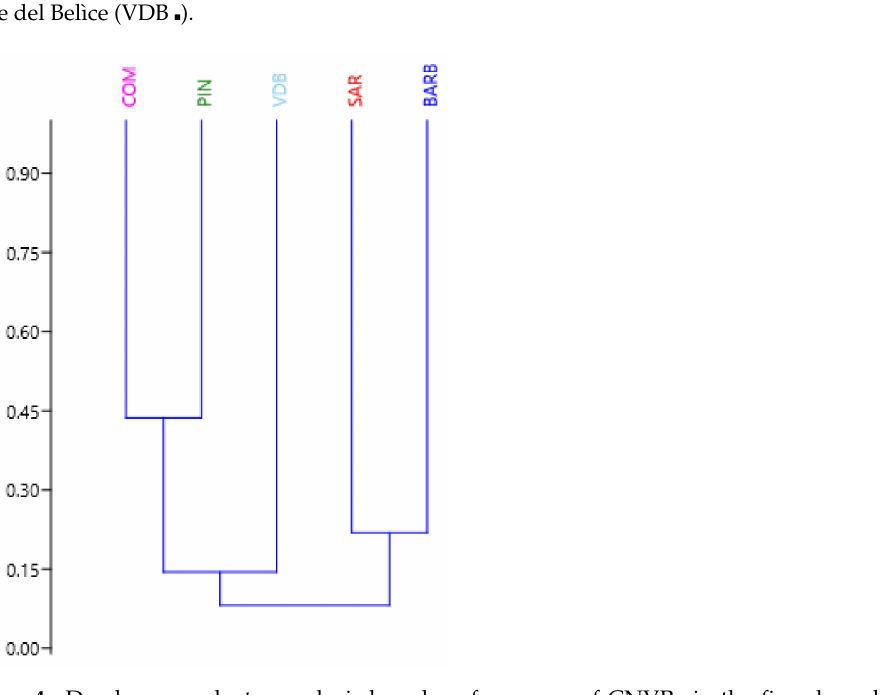
Figure 4. Dendrogram cluster analysis based on frequency of CNVRs in the five sheep breeds. Barbaresca (BARB), Comisana (COM), Pinzirita (PIN), Sarda (SAR), and Valle del Bel ì ce